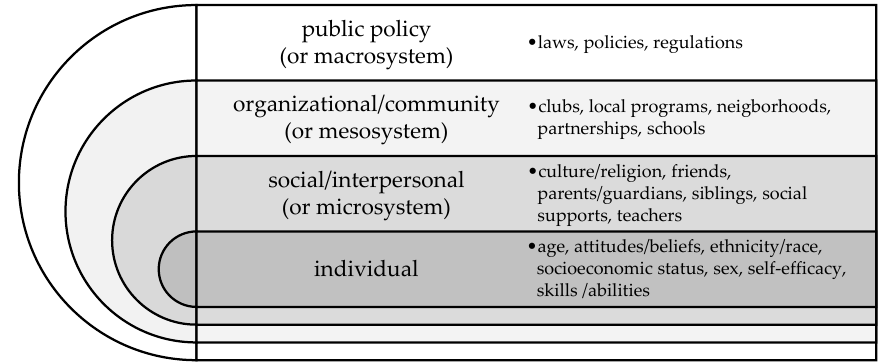
Figure 1. Four systems (individual, social/interpersonal, organizational/community, public policy) of the social ecological model, with specific examples for each level.